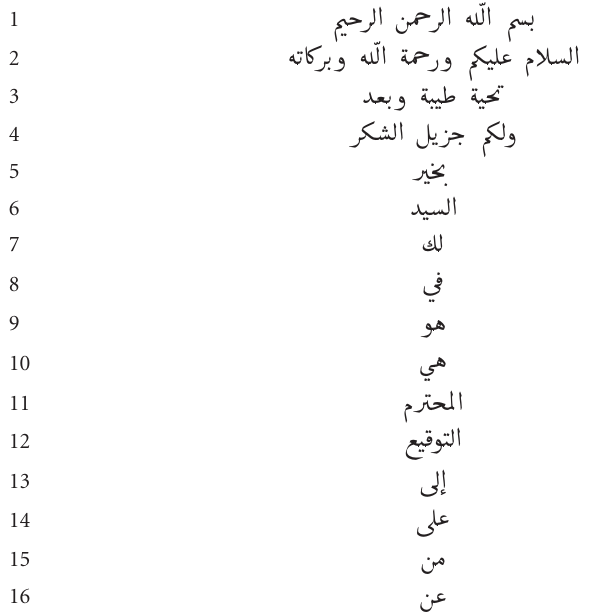
Table 1: Arabic words and phrases most likely to appear in handwritten